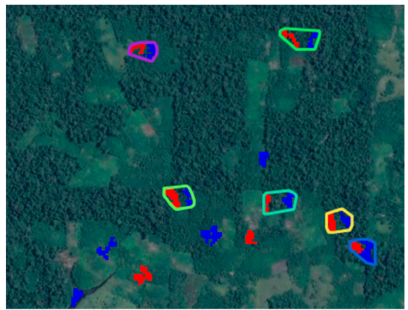
Figure 10. Delineation of deforested patches in a 1.4 km × 1.9 km subset by applying automatic convex envelopes around the pairs of shadows detected in ascending (red) and descending (blue) orbits, respectively corresponding to the western and eastern edges of the deforested patch. Optical background image from Google Earth (© 2018